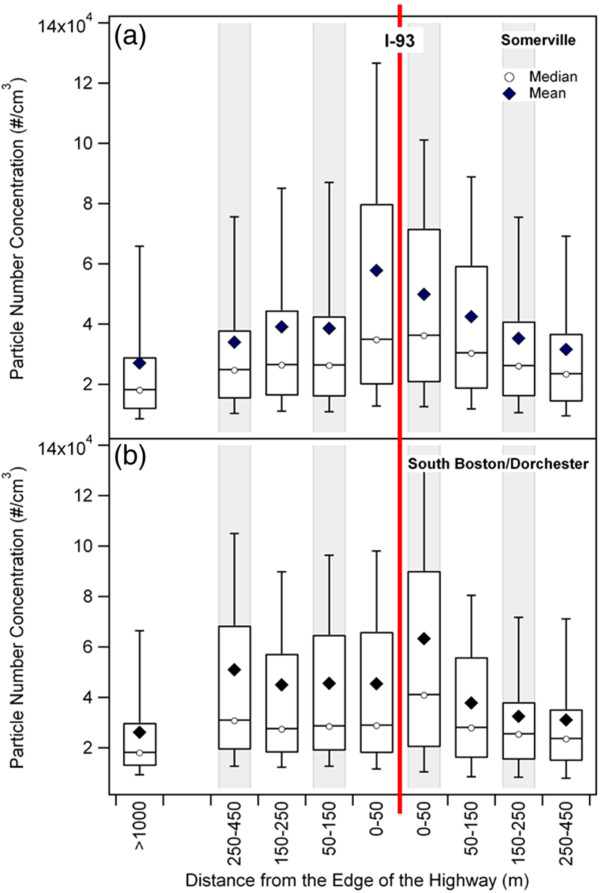
Box plots of 1-second PNC measurements as a function of distance from I-93 for Somerville (a) and Dorchester/South Boston (b). The boxes represent the 25th and 75th percentiles of the data, the whiskers represent the 10th and 90th percentiles. The horizontal solid line in each box represents the median PNC; the black diamond represents the average PNC. The right side of the red line indicates distance to the east of I-93 (generally downwind), and the left side indicates distance to the west of I-93 (generally upwind).